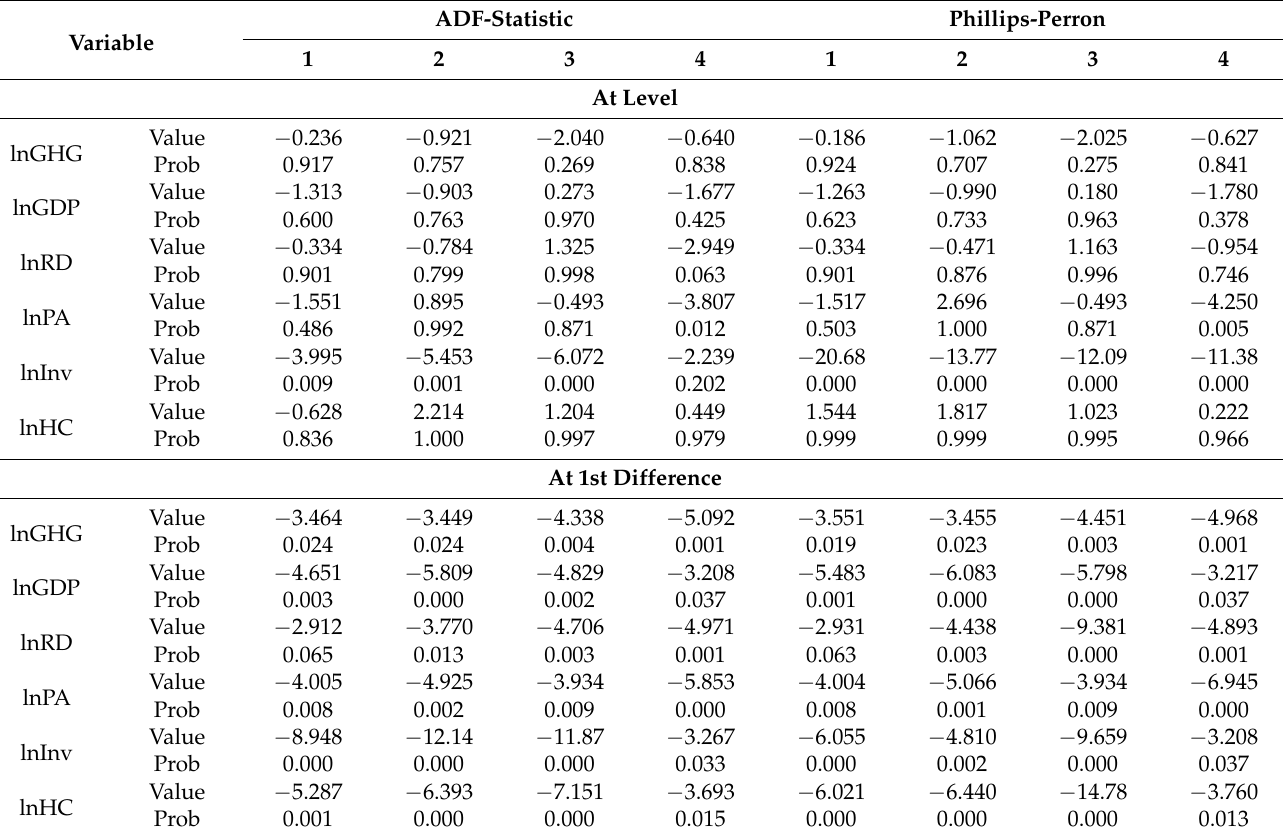
Table 4. Findings of ADF-Statistic and Phillips-Perron tests (Source: developed by the author).